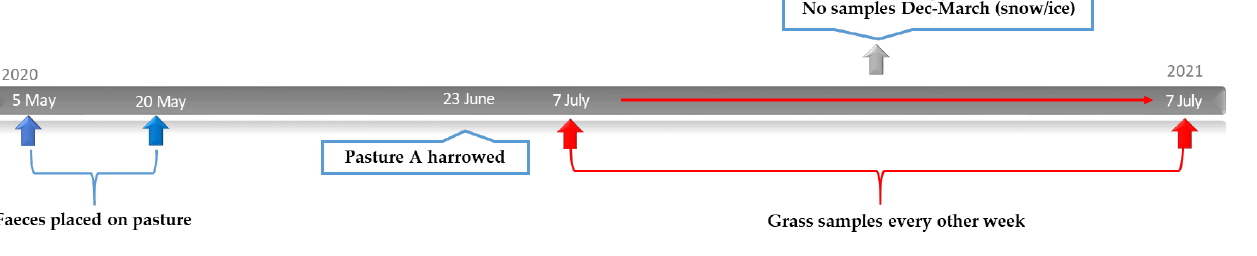
Figure 3. Harrowing study, 2020–2021 : Faecal pats (in total 120 per pasture) were placed on pastures A and B on 15 occasions between 5 May and 20 May. On 23 June, pasture A was harrowed on a single occasion. From 7 July 2020 until 7 July 2021, grass samples for harvesting L3 were collected form pastures A and B approximately every second week, apart from December 2020 – March 2021, due to snow and ice covering the ground.